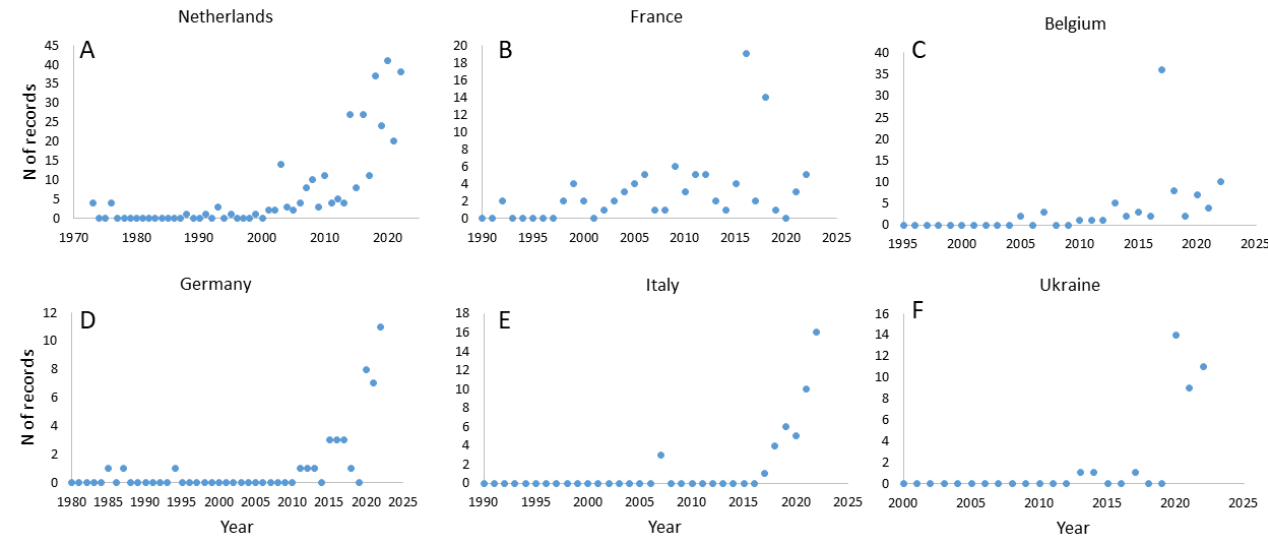
Figure 7. Increase in Pistia stratiotes records in the database GBIF since the year 1980 for selected European countries: ( A ) the Netherlands, ( B ) France, ( C ) Belgium, ( D ) Germany, ( E ) Italy, ( F ) Ukraine.